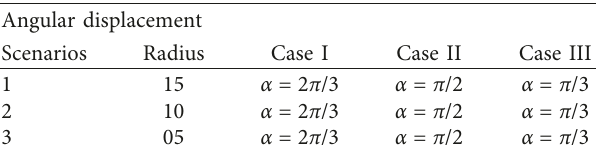
Figure 2: A detailed graphical illustration of the physical problem with its mathematical model, the solution strategy based on the ar- chitecture of cascade learning, and the optimization framework of the Levenberg–Marquardt algorithm to measure the influence of R and α on displacement, velocity, and acceleration of the circular sector. Table 1: Different cases of equation (3) based on variations in radius and angular displacement of a circular sector with A � π /8 and g � 9 . 8m s − 2